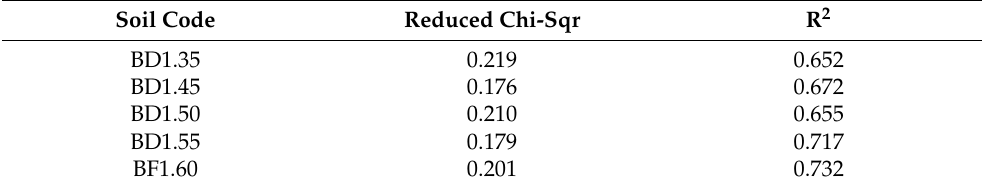
Table 4. Reduced Chi-Sqr and R 2 of the measured value and the Campbell model simulation value for soils with different bulk densities.